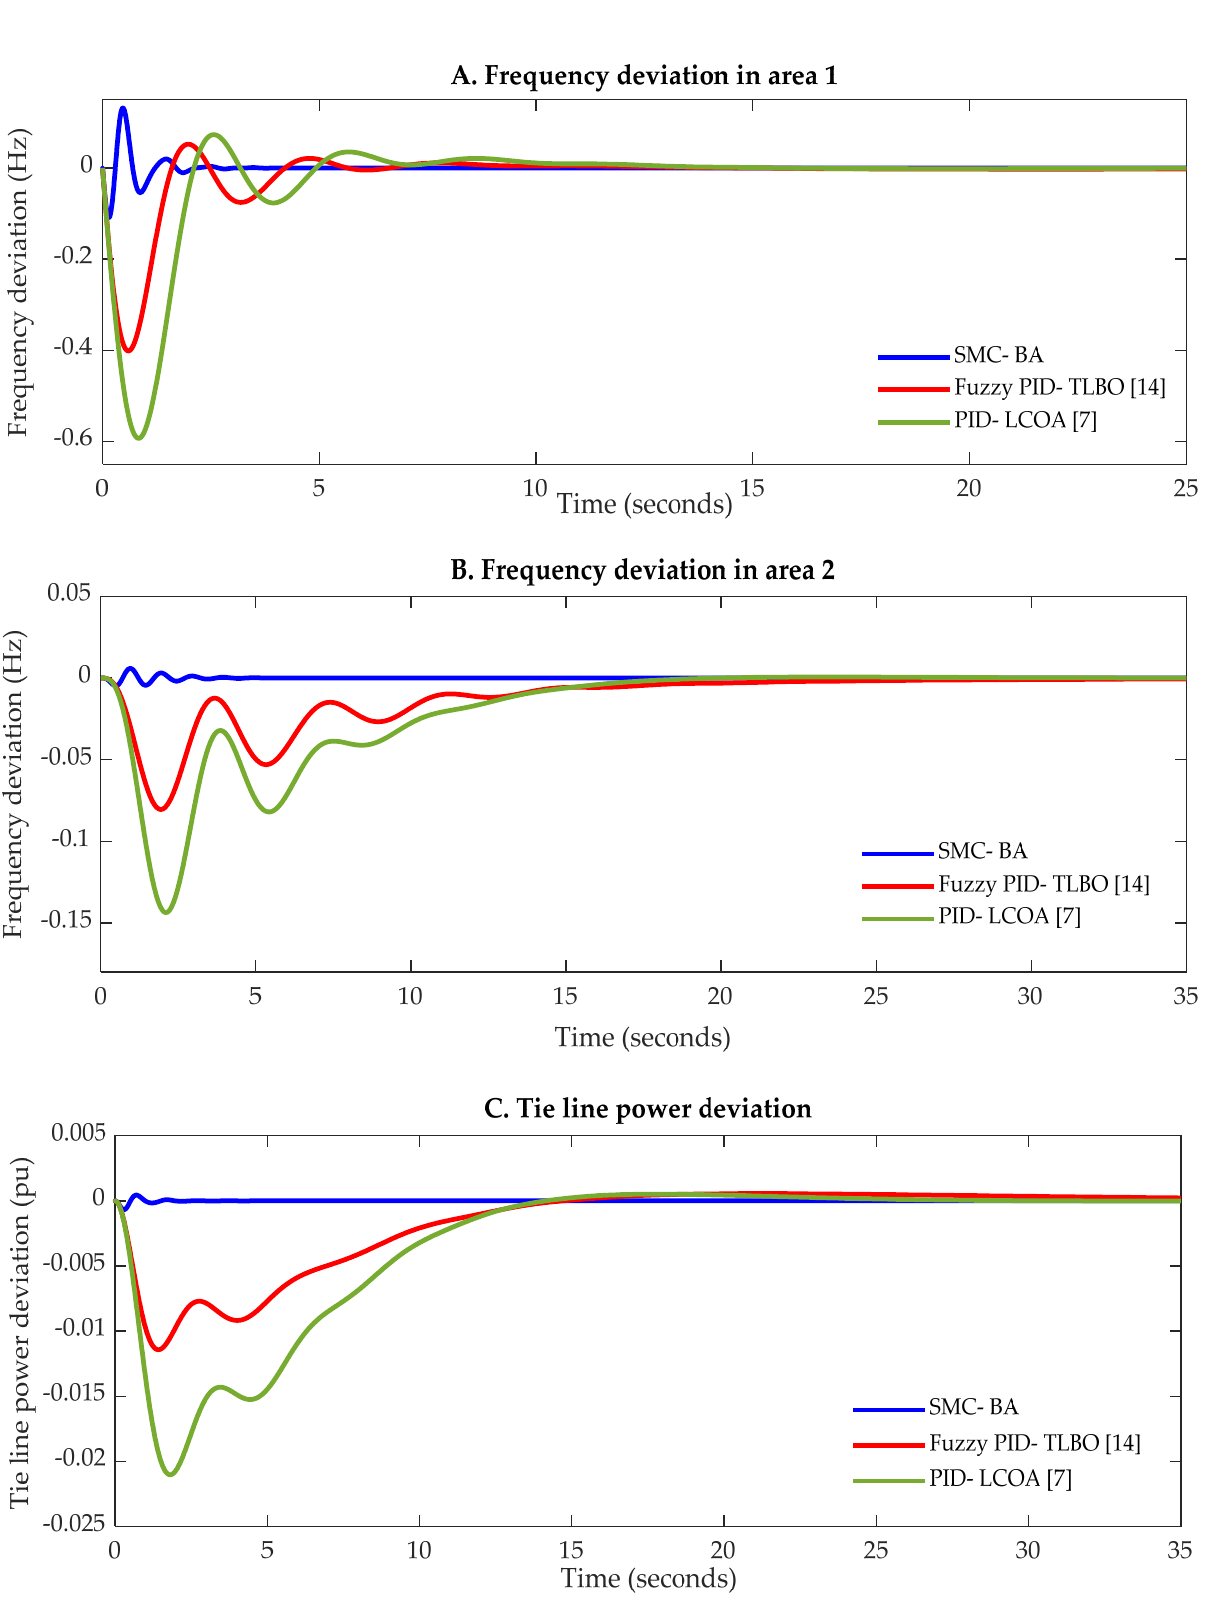
Figure 14. Dynamic response of the system with different controllers under parametric uncertainties, case 8. ( A ) Frequency deviation in area 1; ( B ) Frequency deviation in area 2; ( C ) Tie line power deviation.